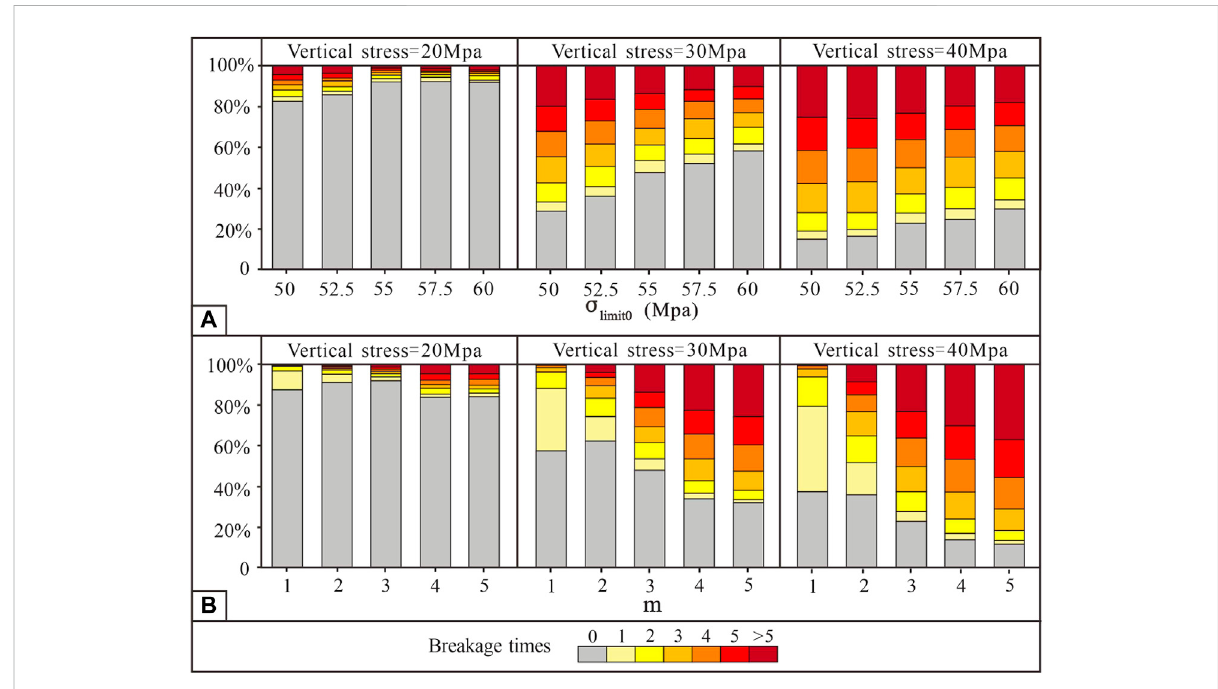
FIGURE 5 The percentage of particles formed by different breakage times: (A) Group A and (B) Group